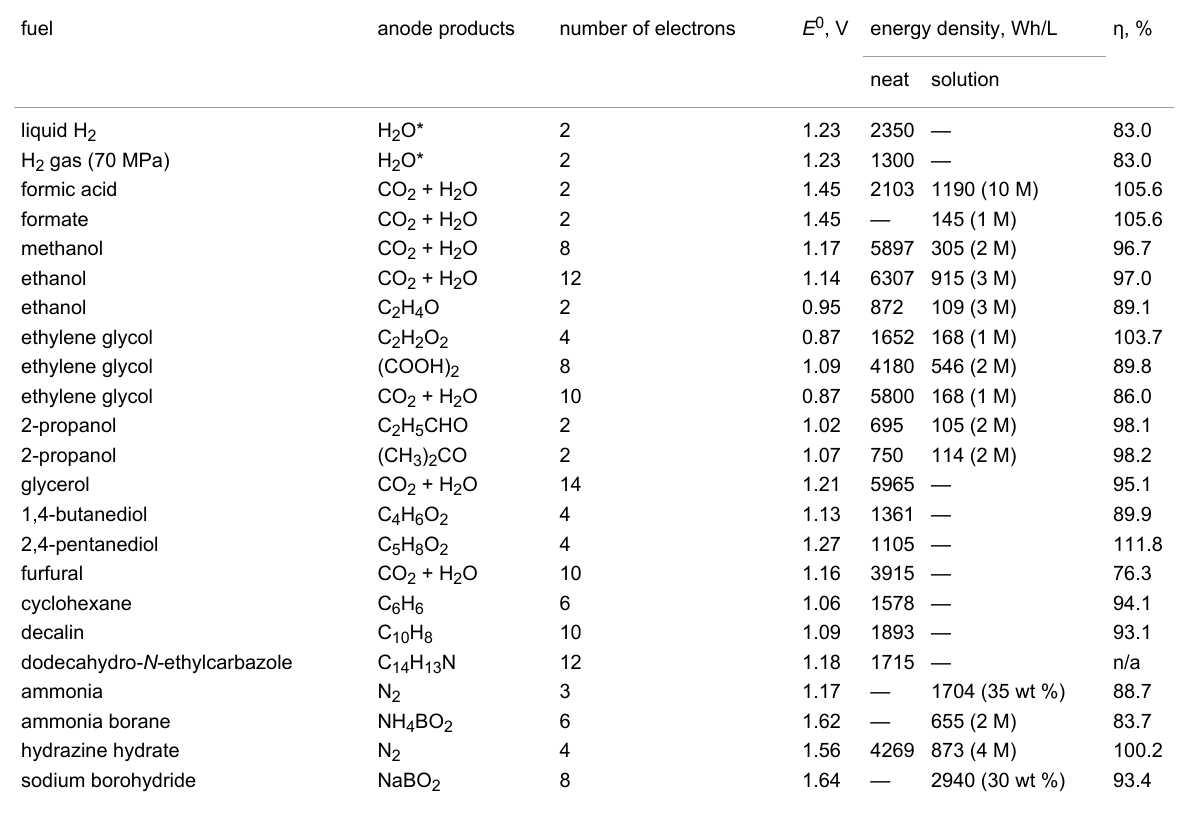
Table 1: Theoretical energy density and fuel cell efficiency for liquid fuels for fuel cells. fuel anode products